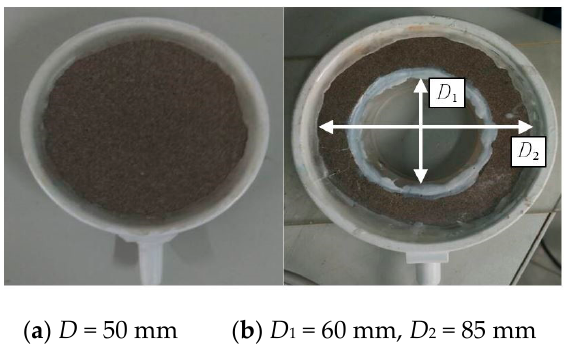
Figure 5. The porous plug used in the physical model.